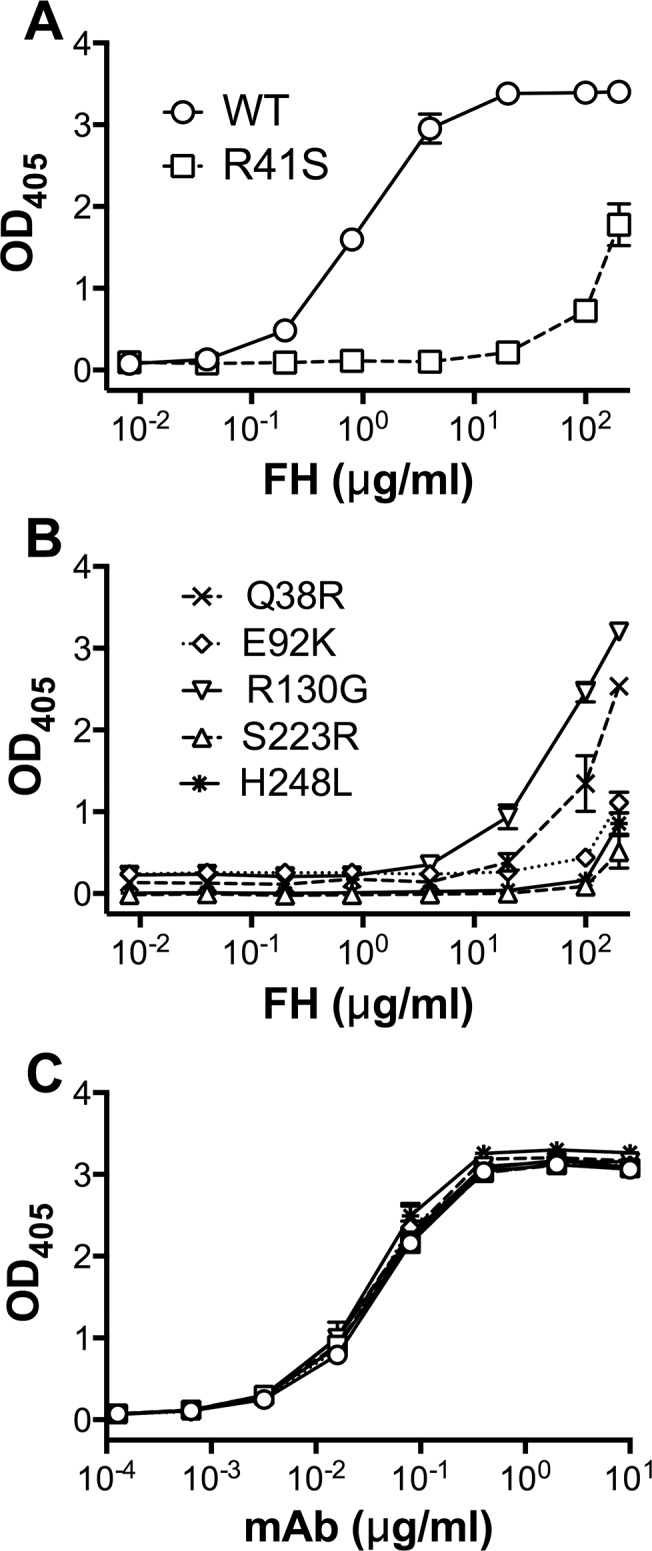
Binding of human FH and a control anti-FHbp mAb to FHbp mutants by ELISA.
A. FHbp wild type (WT) bound human FH, whereas the R41S mutant had decreased binding. B. Binding of FH to the five mutants identified from display library approach. C. Binding of mAb JAR 5, which recognizes an epitope in the N-terminal domain of FHbp [40, 41], to WT, R41S and the five library mutants. In each panel, the mean and range of duplicate measurements are shown.